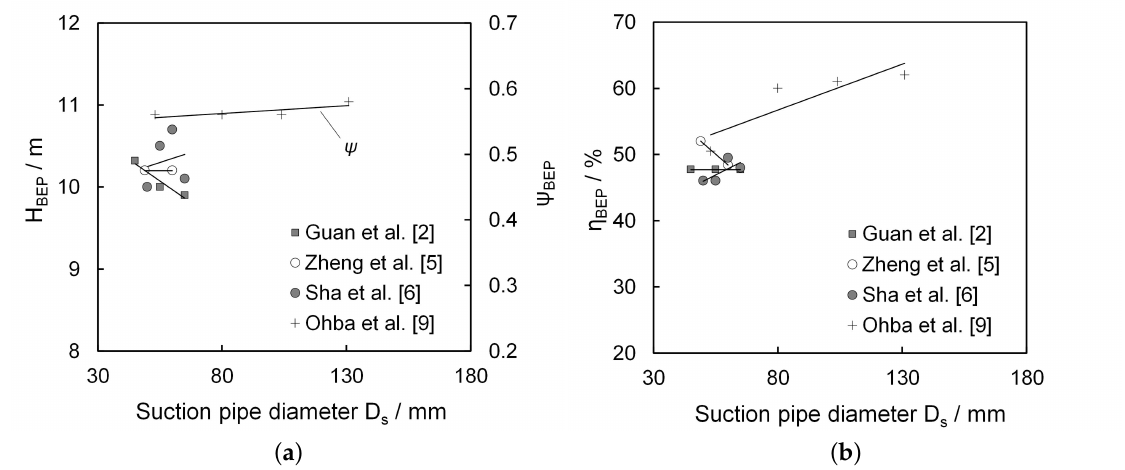
Figure 18. ( a ) Head and pressure coefficient over suction pipe diameter; and ( b ) efficiency over suction pipe